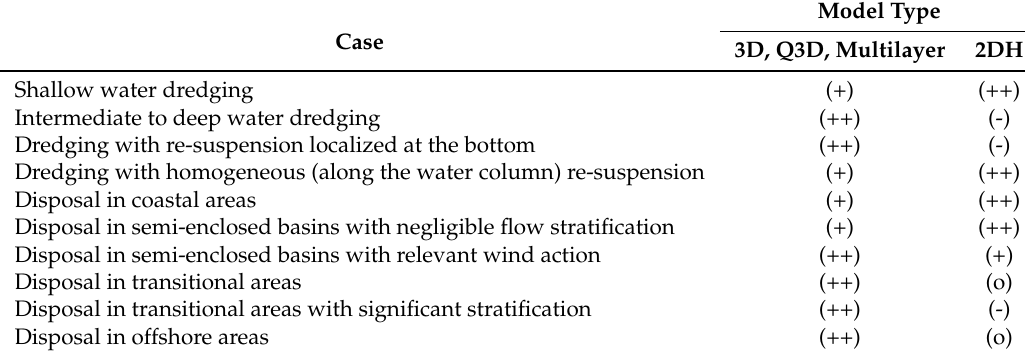
Table 2. Applicability of model type for a series of relevant cases, when model type as well as computational costs are accounted for. (++) suitable (even considering computational load with respect to expected results); (+): possible; (o): not completely suitable, hence the results may be affected by the model formulation; (-): not suitable, hence the results are strongly affected by the model formulation. Model Type Case 3D, Q3D, Multilayer 2DH Shallow water dredging (+) (++) Intermediate to deep water dredging (++) (-) Dredging with re-suspension localized at the bottom (++) (-) Dredging with homogeneous (along the water column) re-suspension (+) (++) Disposal in coastal areas Disposal in semi-enclosed basins with negligible flow